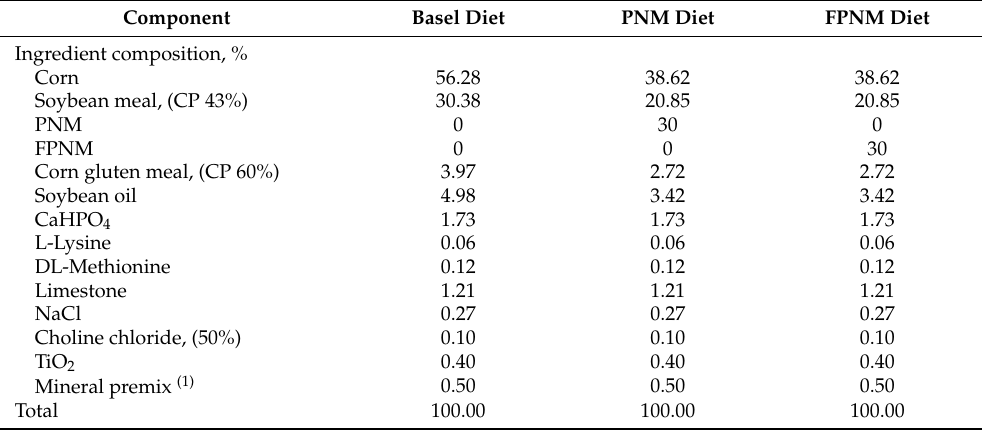
Table 2. Ingredient composition and nutrient concentration of the basal diet used in the determination of the apparent metabolizable energy (dry matter